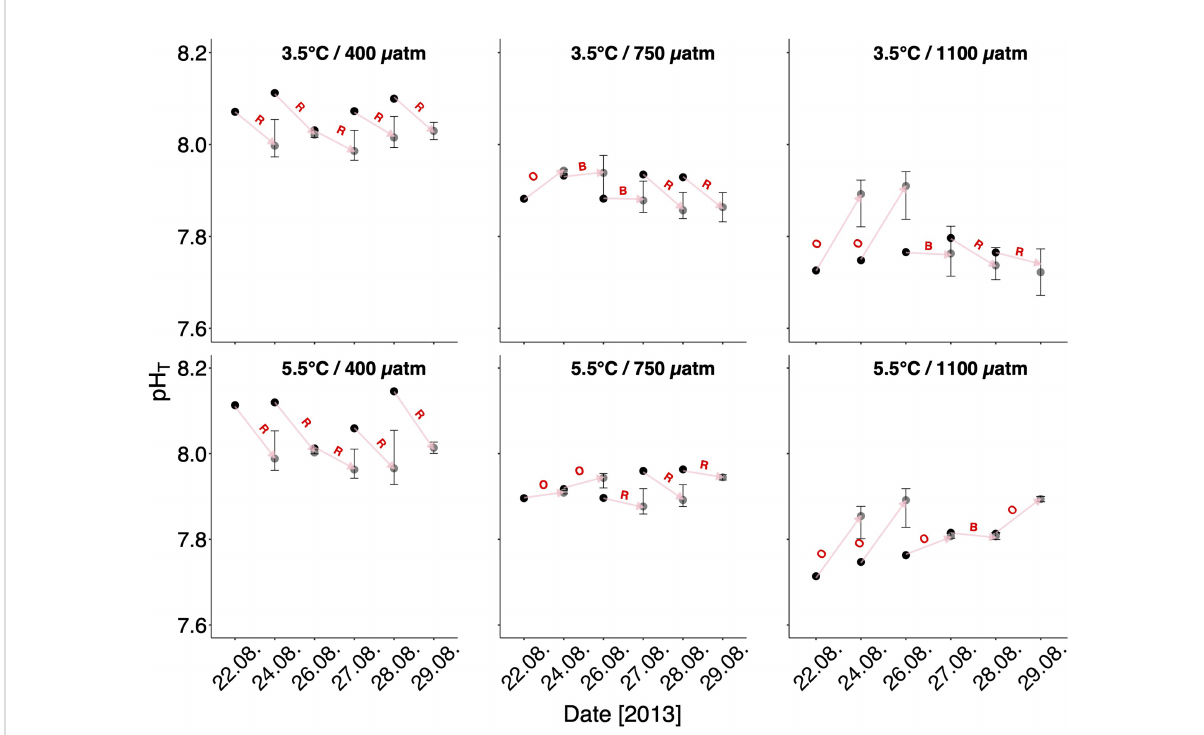
FIGURE 7 pH T of the CO 2 -manipulated seawater in the storage containers (black dots) and development of mean pH T in the single dishes (experimental units) measured prior each water exchange and at the experiment termination (gray dots). Error bars are con fi dence intervals. Arrows connect the pH T development of the fresh manipulated seawater to the corresponding pH T in the dishes prior each water exchange. Letters indicate the dominant process that determined the pH to increase or decrease between each water exchange, respectively. R, respiration; O, outgassing; B, balance between respiration and